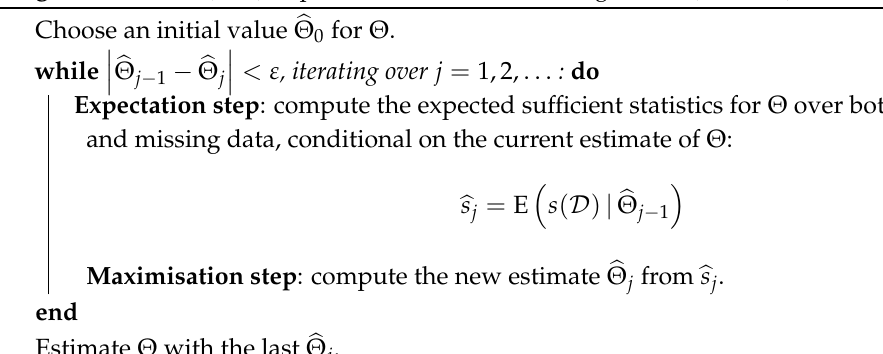
Algorithm 1: The (Soft) Expectation-Maximisation Algorithm (Soft EM) Choose an initial value (cid:98) Θ 0 for Θ .